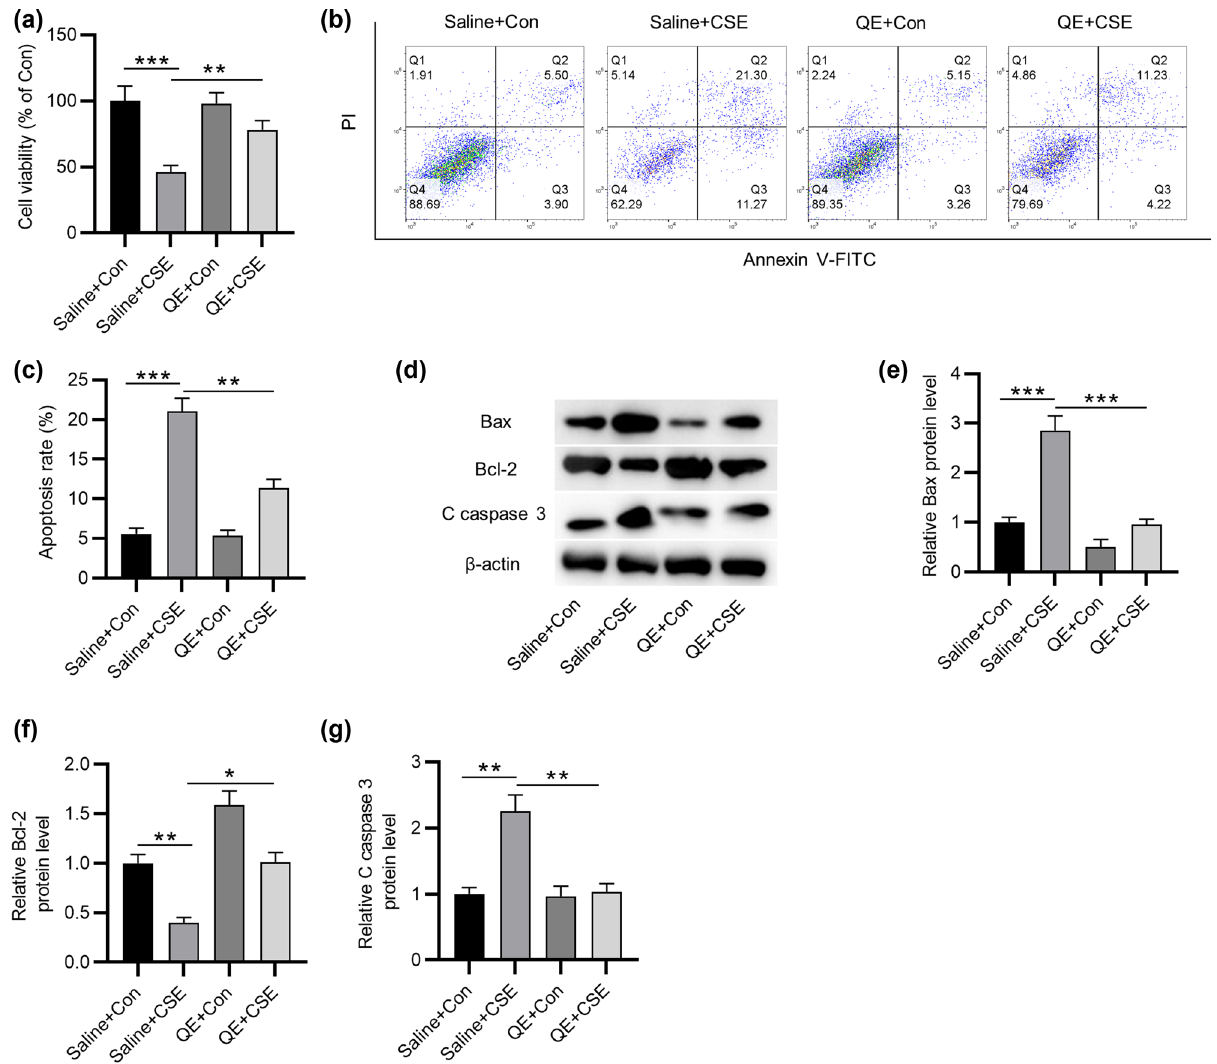
Figure 2: E ff ects of QE on the viability and apoptosis of CSE - treated HBECs. ( a ) CCK - 8 assay was applied to measure lung epithelial cell viability in saline + Con group, saline + CSE group, QE + Con group, and QE + CSE group. ( b and c ) Flow cytometry analysis was used to evaluate lung epithelial cell apoptosis in each group. ( d – g ) Western blotting was performed to detect protein levels of Bax, Bcl - 2, and cleaved caspase - 3 in HBECs in each group. * p < 0.05, ** p < 0.01, and *** p <